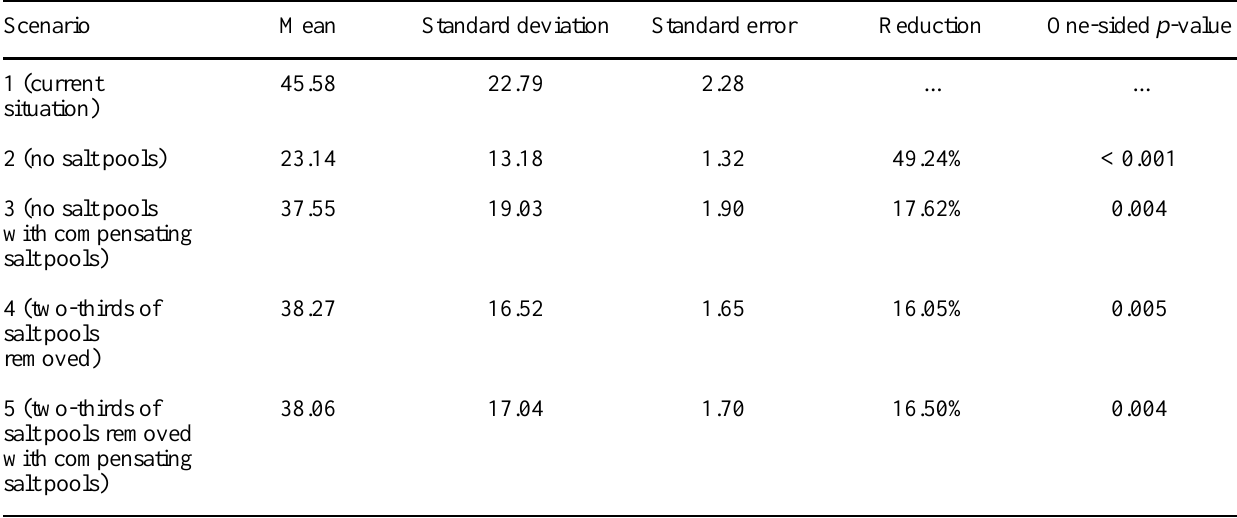
Table 5 . Number of road crossings by model moose while traveling during the summer period according to five different modeling scenarios. Modeling scenarios differed from each other with respect to the degree of salt pool removal and the creation of compensatory salt pools. We conducted 100 runs per scenario. Standard error is equal to the standard deviation divided by the square root of the sample number.